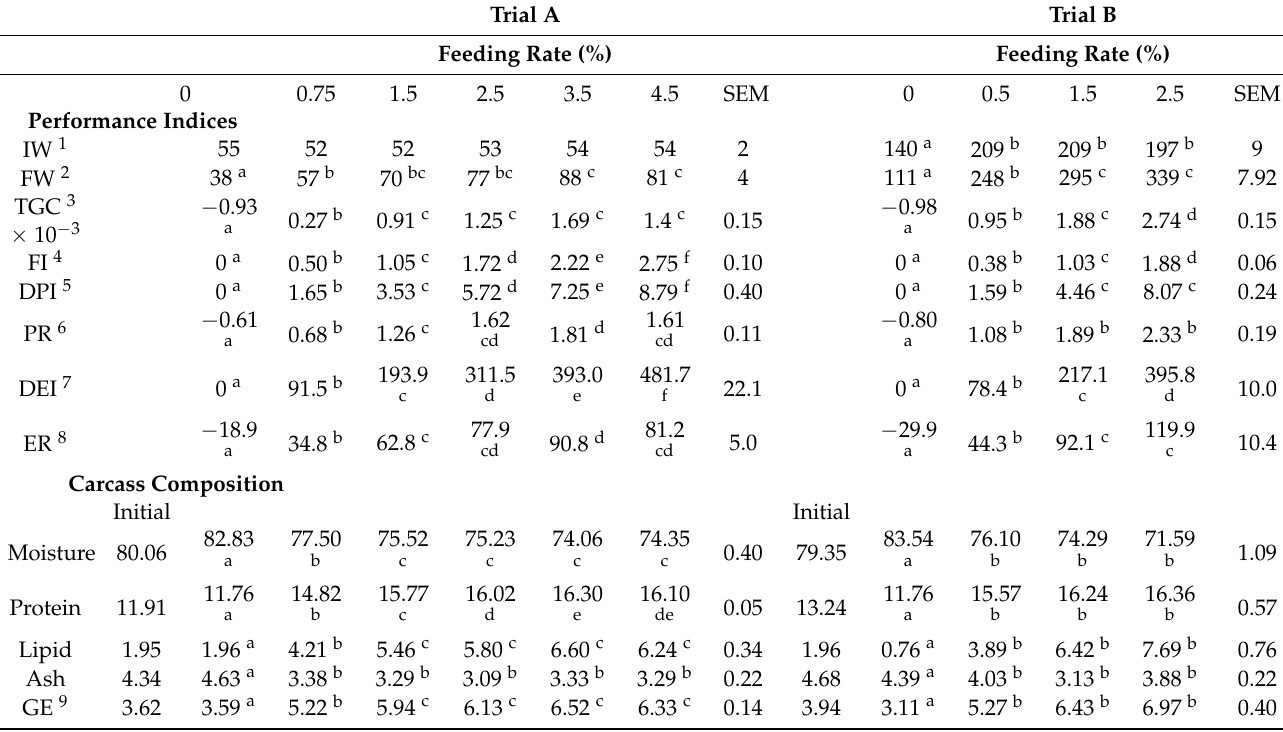
Table 3. Growth and parameters of the two experiments of Argyrosomus regius fed at different feeding rates and corporal analysis of A. regius fed at different feeding rates at the end of the trial. Trial A Trial B Feeding Rate (%) Feeding Rate (%)